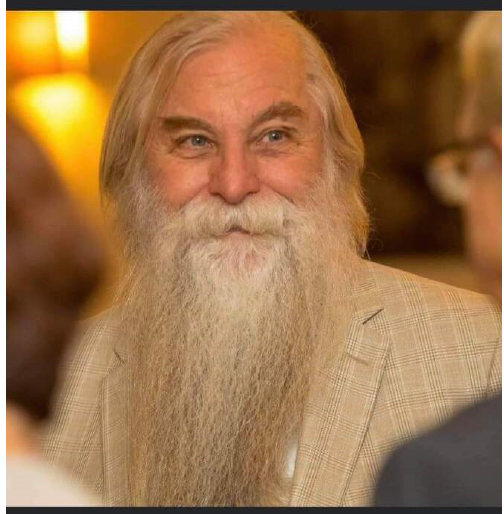
Figure 3. Dr. Randall J. Cohrs. Photo permitted for use by the Cohrs family.